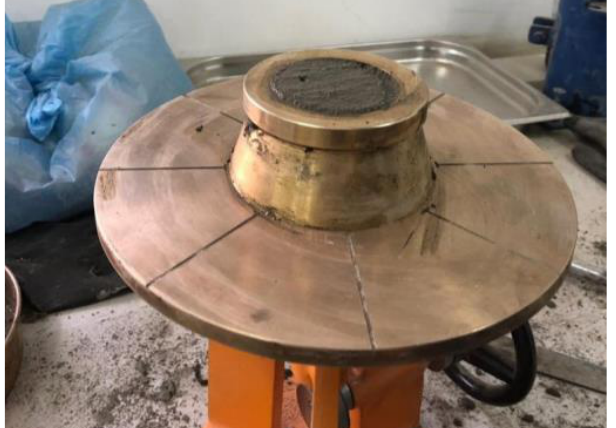
Figure 5. Workability test.